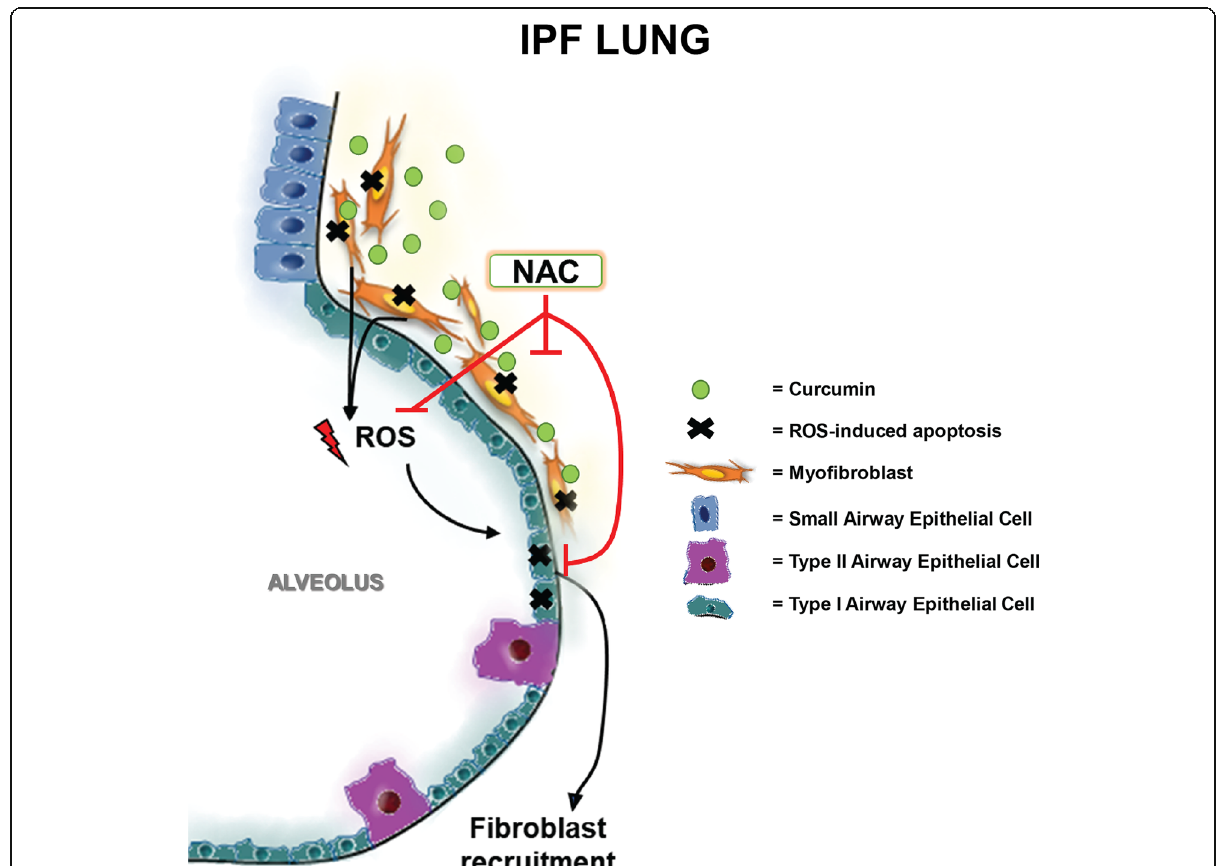
Fig. 7 Hypothetical Molecular Model of Curcumin and NAC Co-Treatment in IPF: Curcumin induces ROS mediated apoptosis in myofibroblasts releases excess ROS into the microenvironment. As the IPF lung is an oxidative stress rich environment the excess ROS further damages epithelial cells in the lung. This propagates the wound healing response and may further induce fibrosis in a classical IPF feedforward loop. The introduction of NAC co-treatment attenuates fibroblast apoptosis and alleviates ROS induced oxidative stress in epithelial cells. In turn this prevents additional fibroblast recruitment. Deduction of optimal in-vivo co-treatment concentrations may result in significant antifibrotic potential for therapeutic